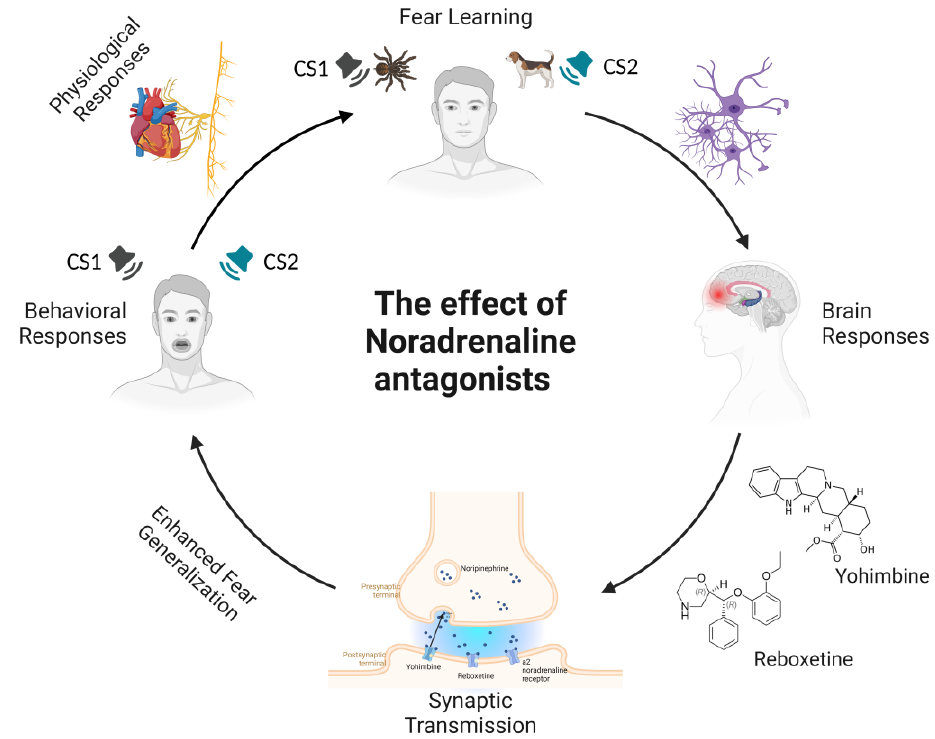
Figure 2. Schematic representation of noradrenergic modulation during fear learning by the ad- ministration of adrenergic antagonists. In fear-learning paradigms, following the pairing of a neutral stimulus with an innately aversive stimulus, conditioned fear responses develop after the presentation of the conditioned stimulus alone. Exposure to aversive events leads to the release of neurotransmitters, such as noradrenaline (NA). Specifically, NA is released from noradrenergic nerve terminals, where it diffuses across the synaptic cleft and activates adrenergic receptors to elicit a postsynaptic effect. Noradrenergic antagonists in presynaptic terminals act by decreasing the inhibitory influence of the α2-adrenoceptor on noradrenaline release. This causes the enhancement of fear memory and increased fear generalization, an active process that refers to an increased ability to discriminate between CS1 and CS2, leading to increased retrieval of fear memory and fear ex- pression. Notes. CS1 = Conditioned stimulus 1; CS2 = Conditioned stimulus 2; NA = noradrenaline.